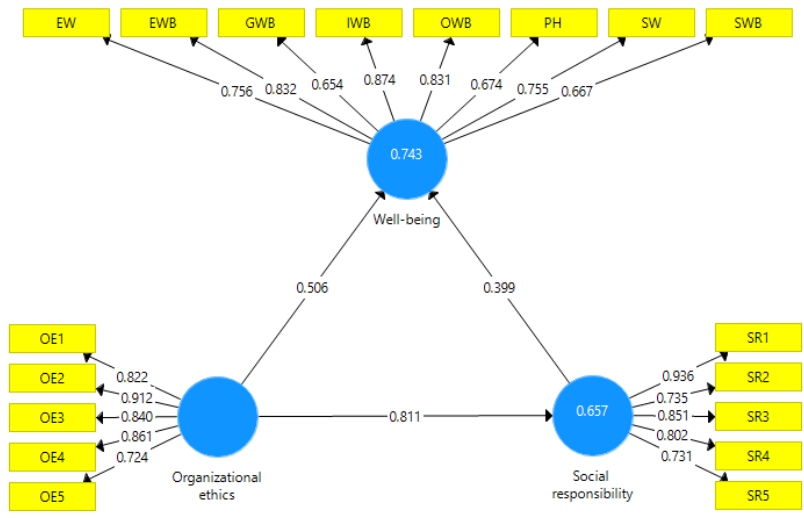
Figure 3. Preliminary model. Source: designed by authors using SmartPLS 3.0 (SmartPLS GmbH, Oststeinbek, Germany).